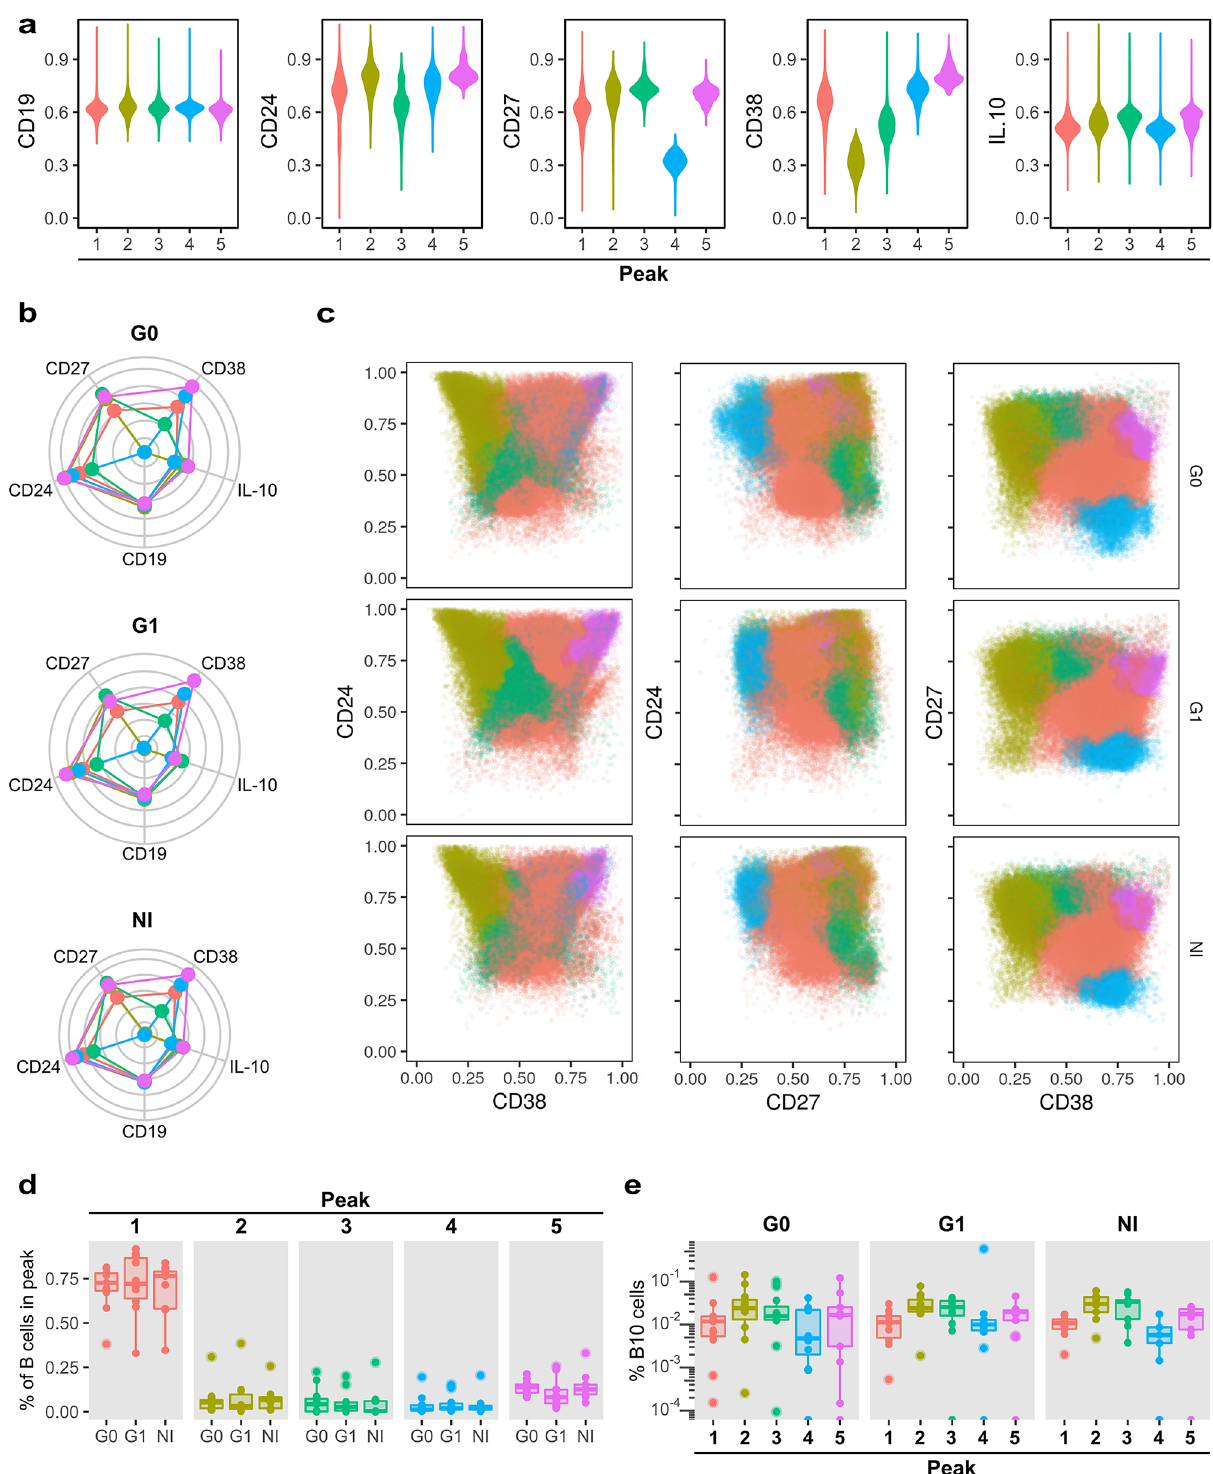
Figure 6. Automatic gating performed by flowPeaks algorithm of B cell subsets based on CD19, CD24, CD27 and CD38 expression. ( a ) Violin plots show the distribution of the expression of each marker for each peak. ( b ) Spider plots display the median expression for each marker in the different peaks. One graph is shown for each group of CCD patients (G0, G1) and non-infected donors (NI). ( c ) Representative biaxial dot plots showing the distribution of peaks based on CD24-CD38, CD24-CD27 and CD27-CD38 expression. ( d ) Box plots showing the percentage of B cells within each peak in G0, G1 and NI groups. ( e ) Box plots indicate the percentage of B10 cells within each peak in the G0, G1 and NI